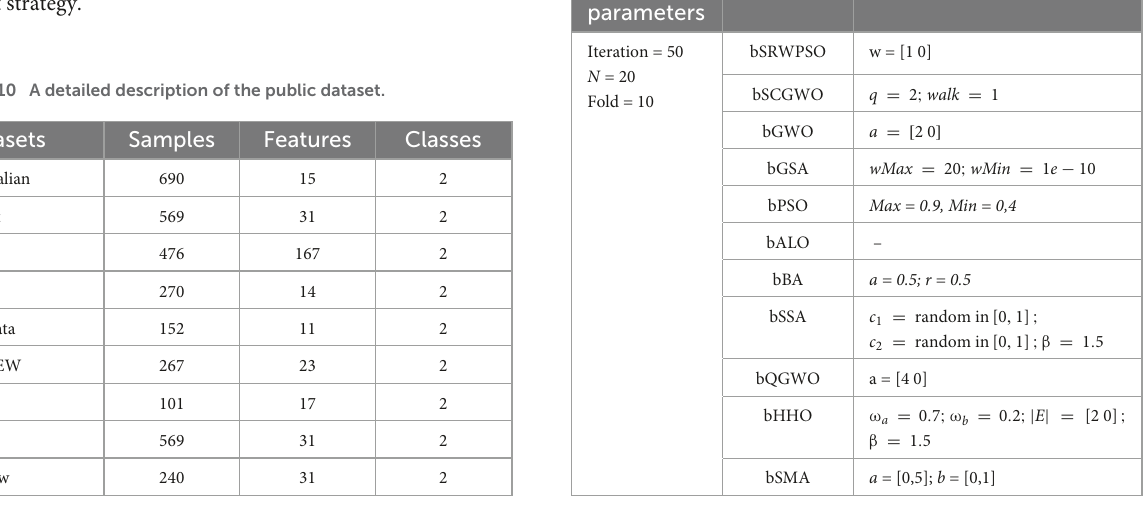
impact of three improved strategies on the performance of PSO based on the CEC 2014 benchmark function set. Table 5 shows the different combinations in the improvement process. In the table, the SOB represents the Sobol initialization strategy, the RRS represents the random replacement strategy, and the AWS represents the adaptive weight strategy.